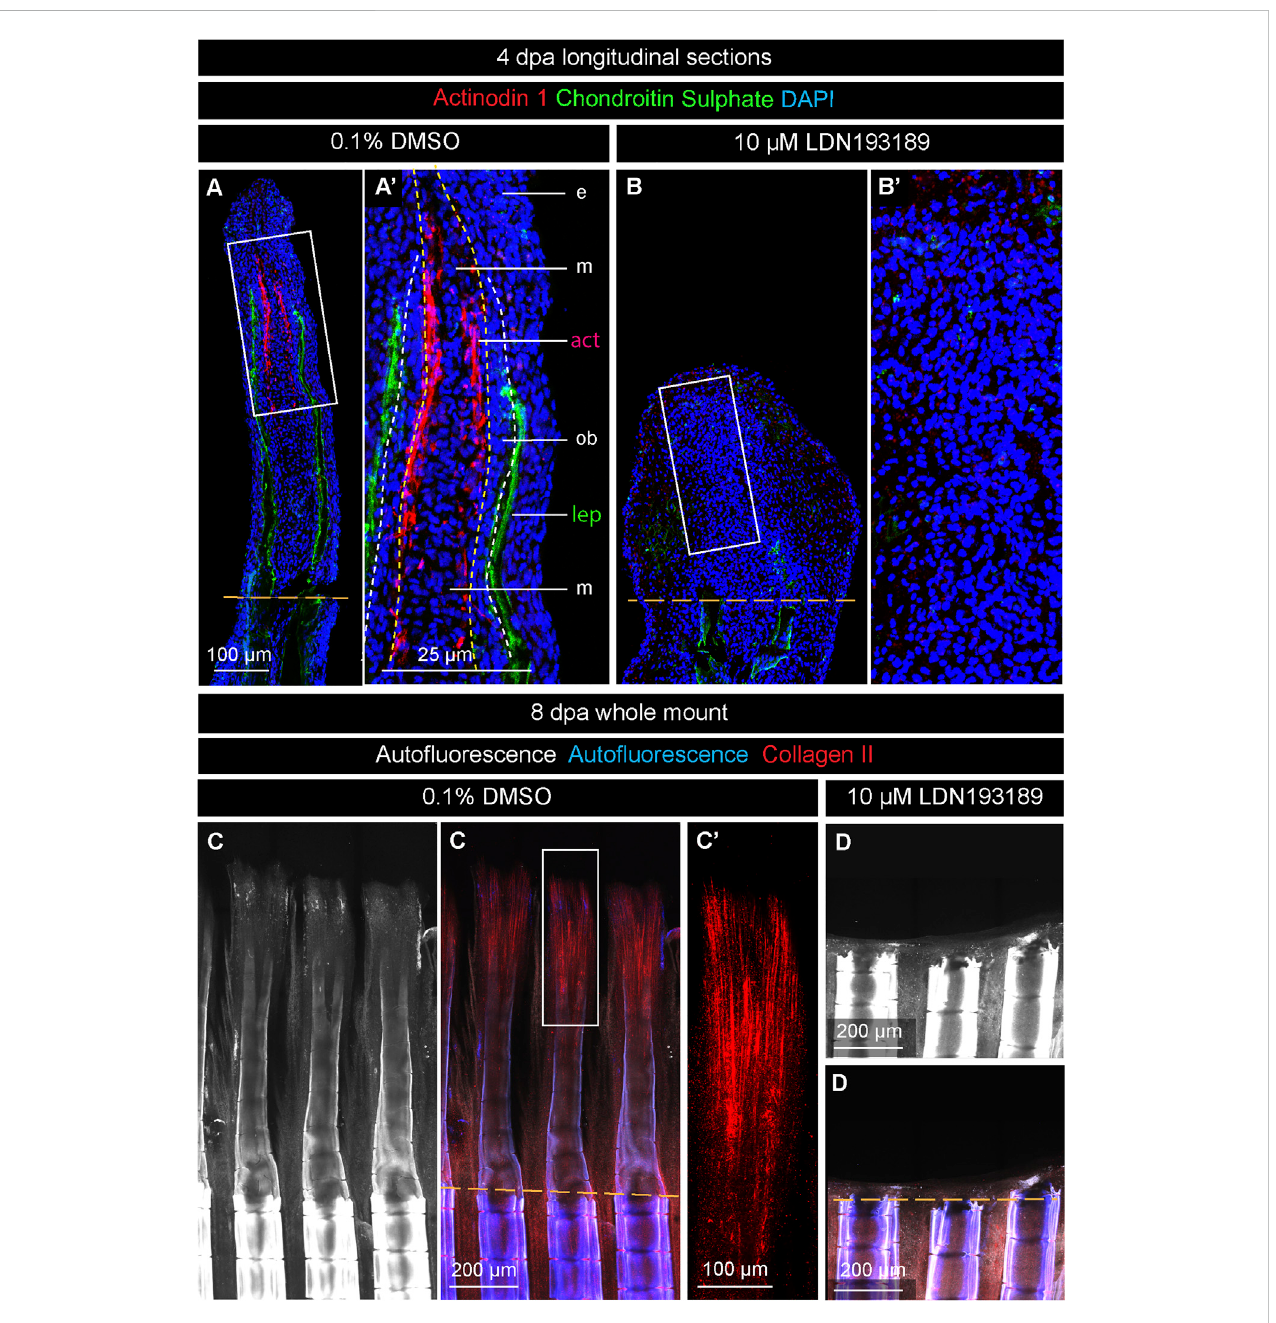
FIGURE 7 BMP inhibition prevents actinotrichia regeneration. (A and B) Immuno fl uorescence staining of fi n sections at 4 dpa with antibodies against chondroitin sulphate(green)tovisualizelepidotrichia (lep),andActinodin1(red),amarkerofactinotrichia(act).DAPI(blue)demarcatesnuclei.Orange dashedlinesdepict the amputation plane; white dashed lines underly the basal epithelium; yellow dashed line demarcates the boundary between osteoblasts (ob) and mesenchyme (m). e, epidermis. The actinotrichia are located beneath the layer of osteoblasts in control. No Actinodin-1 protein is detected in LDN193189-treated fi ns. (C and D) Fin whole mounts with Collagen II antibody staining (red). The intensity of auto fl uorescence (white and blue) re fl ects the levelofbonecalci fi cation.Thisparameterindicatestheplaneofamputation(dashedorangeline).(C ′ )Ahighermagni fi cationoftheframedareain (C) displays actinotrichia at the tip of a ray. (D) No Collagen II expression is detected in LDN193189-treated fi